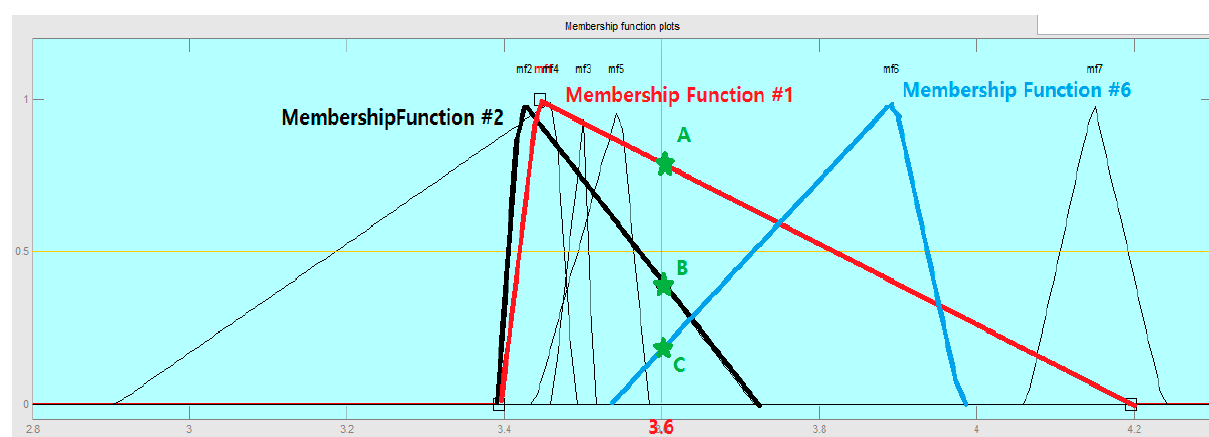
Figure 8. Example of a Membership Function: the vertical axis is Membership Function, and the horizontal axis is the traffic volume: Membership function #1~7 means sequentially from distribution of Sunday traffic volume to Saturday traffic volume.